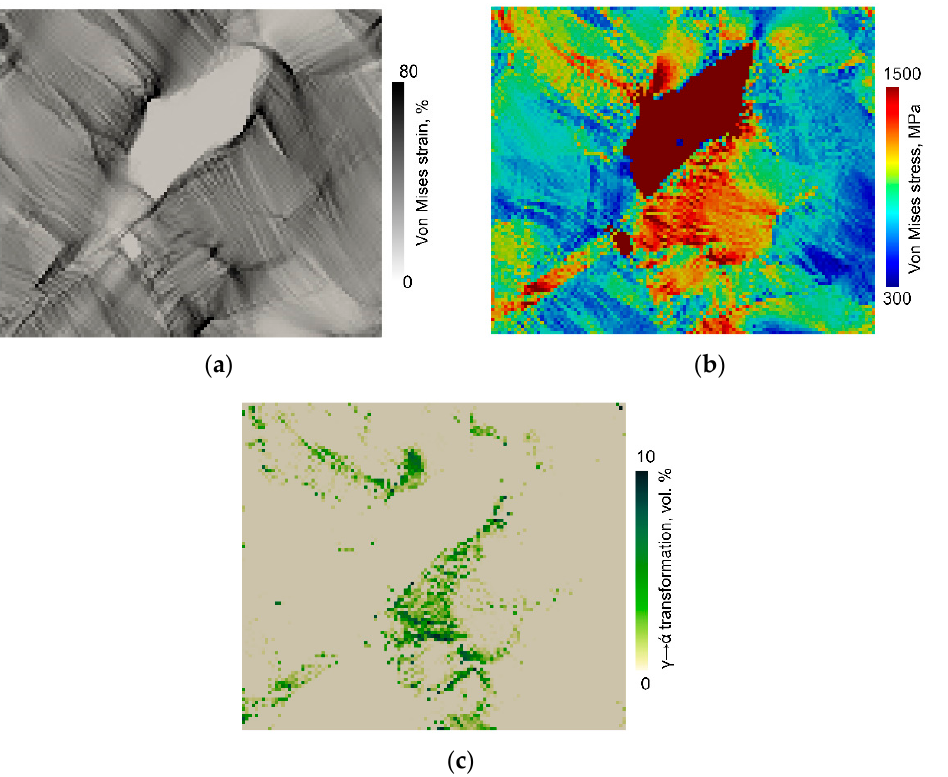
Figure 11. Visualization of the local results at 25% of the true global strain in the MMC simulation model developed from actual EBSD data: ( a ) logarithmic von Mises strain; ( b ) von Mises–Cauchy stress; ( c ) martensitic transformation volume.